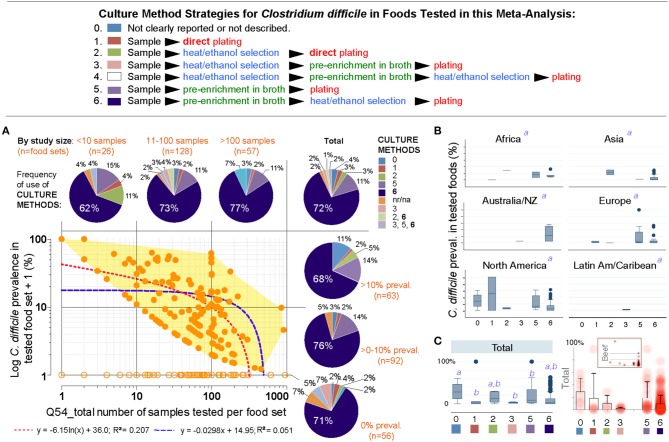
The isolation of C. difficile from foods is independent of the culture methods. (A) Overview of culture sequence/strategies. (B) Distribution of culture methods (pie charts) across the spectrum of study size or reported prevalences in this systematic review (scatter plot and best univariate linear fit models). Most studies used the enrichment method described by Rodriguez-Palacios et al., since fist studies reporting C. difficile in food-producing young animals, and retail beef (9, 10) (dark blue in pie charts, #6). na/nr, not reported. (B) Boxplots of reported prevalences across regions. Controlling for study name, geographical region, and culture method, there are no differences across regions in the log norm prevalence data in multivariable analysis (italic superscript “a,” adjusted p > 0.1; generalized linear model: outcome, a99a_percentplus1log; categorical variables, a46a_overall_cult_apprch a9_pub_region a5_stydy_id). (C) Cumulative standard boxplot and density scatter boxplot of reported prevalences across culture method. Inset, Density scatter boxplot for beef samples illustrates reproducibility of cumulative data.